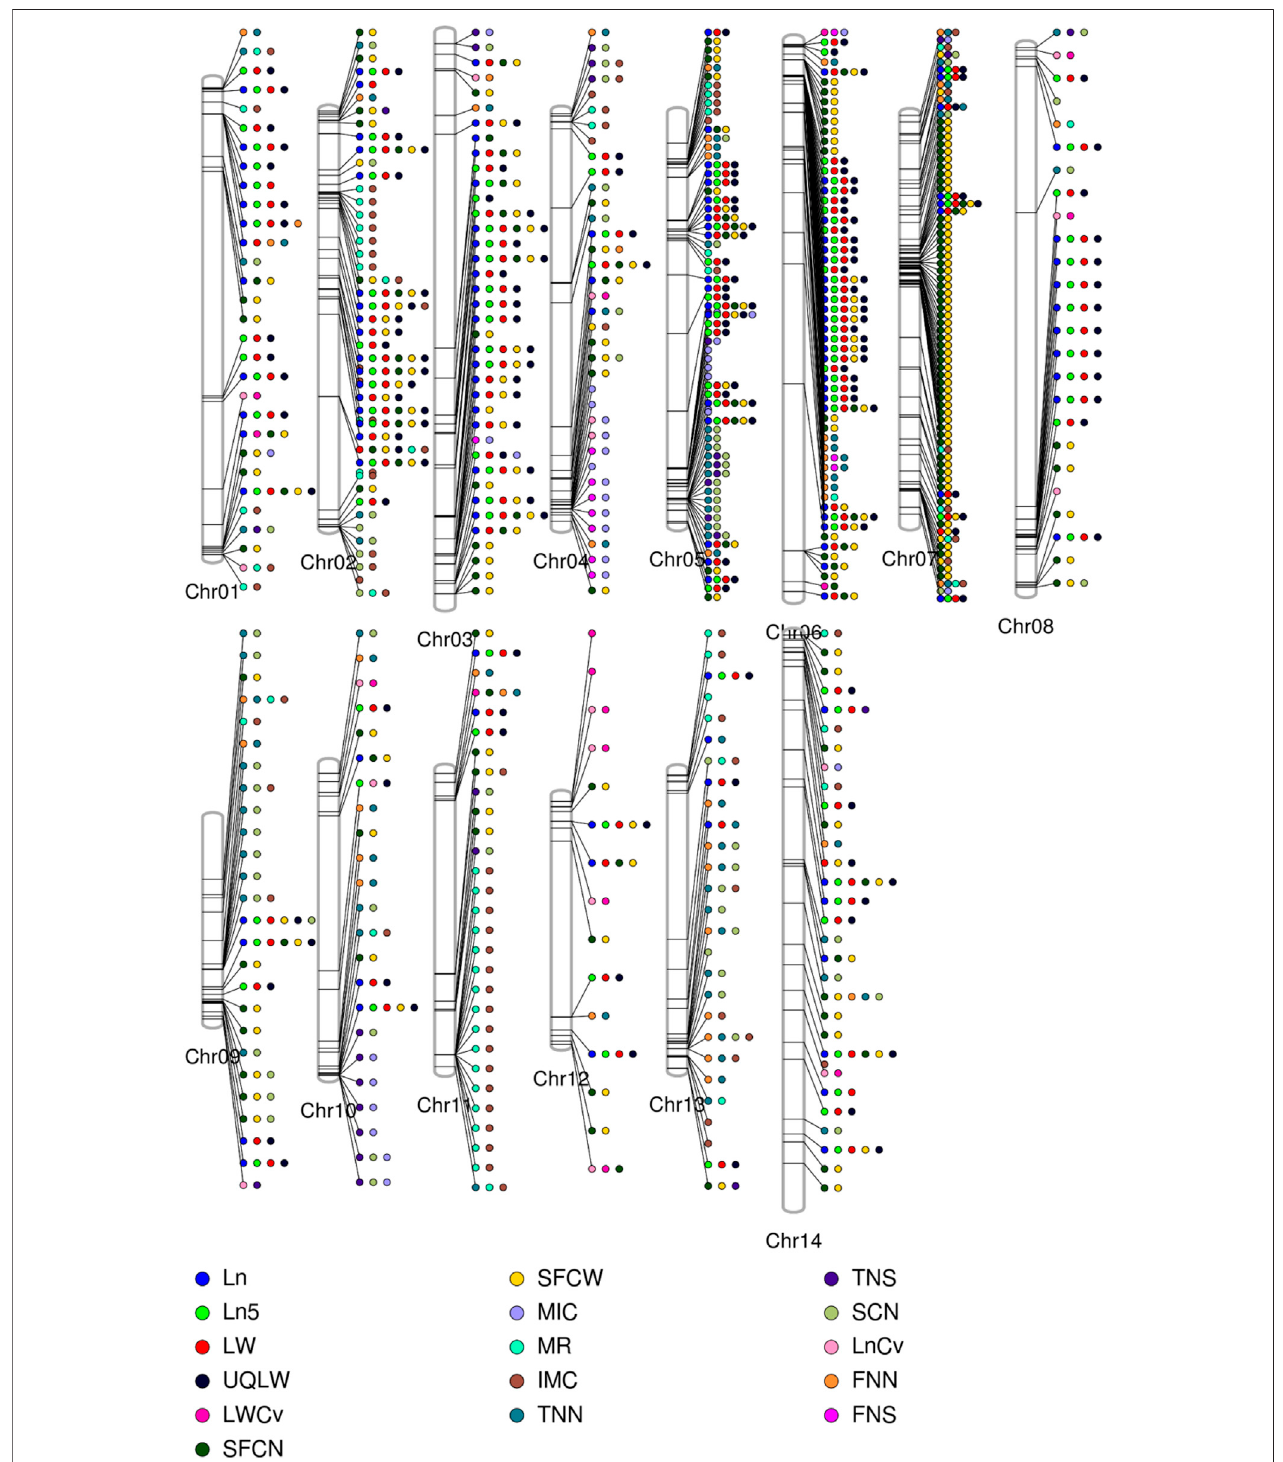
FIGURE4| Phenogramisdisplayingpeakassociationssignalsfrom7429signi fi cantlyassociatedSNPs forsingle fi ber qualitytraitsacrossdifferentchromosomes of Asiatic Cotton. Legends at the bottom are for distinguishing different studied traits.